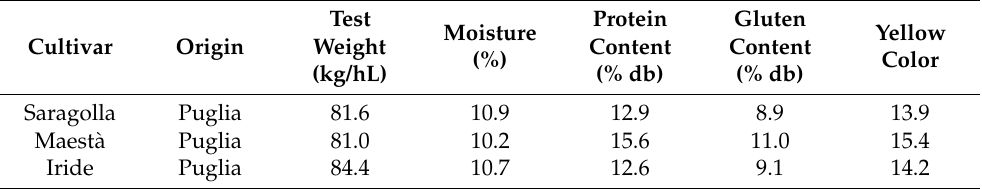
Table 1. Durum wheat cultivars, origin (region of Italy), and proximate quality parameters measured by NIT. Mean values of replicated analyses (n =